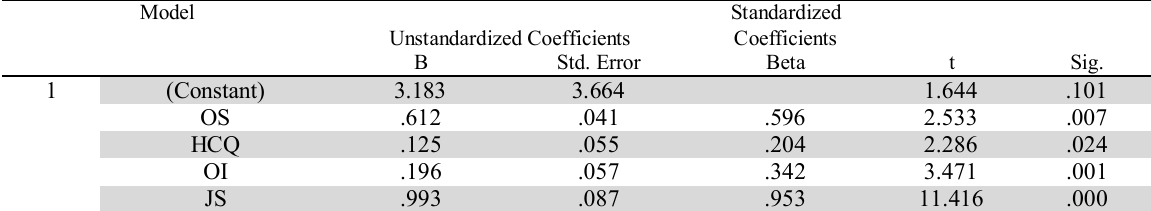
The summary of regression